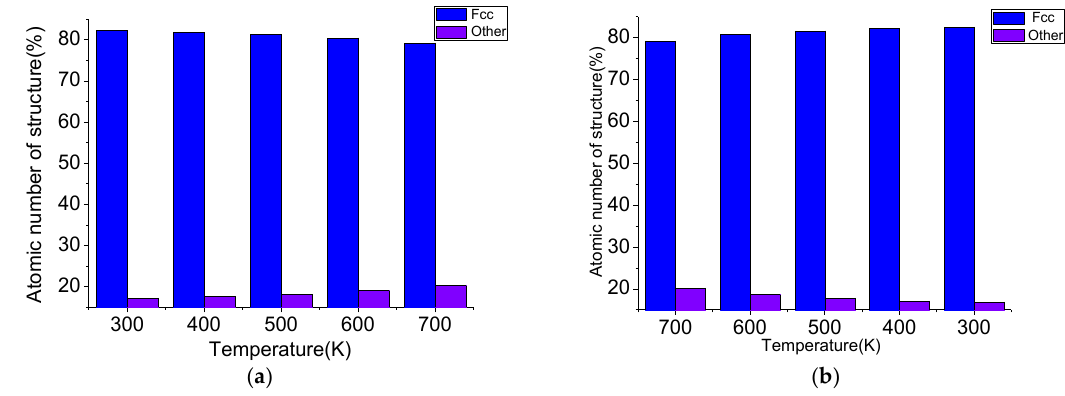
Figure 4. The atomic number of the structure during annealing: ( a ) the atomic number of the structure during heating; ( b ) the atomic number of the structure during cooling.